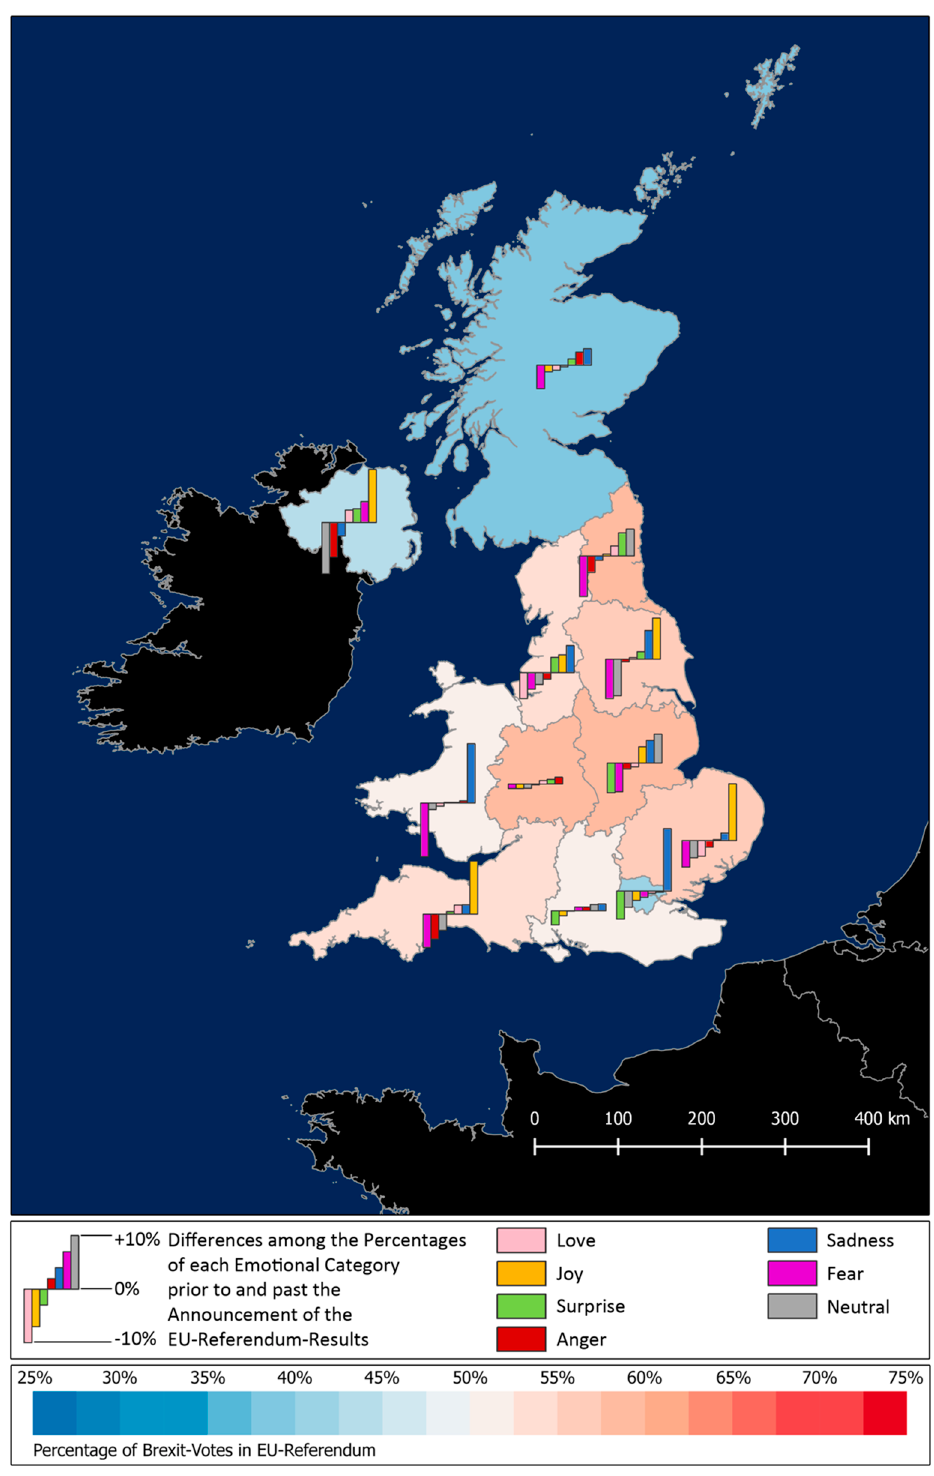
Figure 10. Results of the EU referendum and differences among the percentages of emotions prior to and past the announcement of the referendum results.